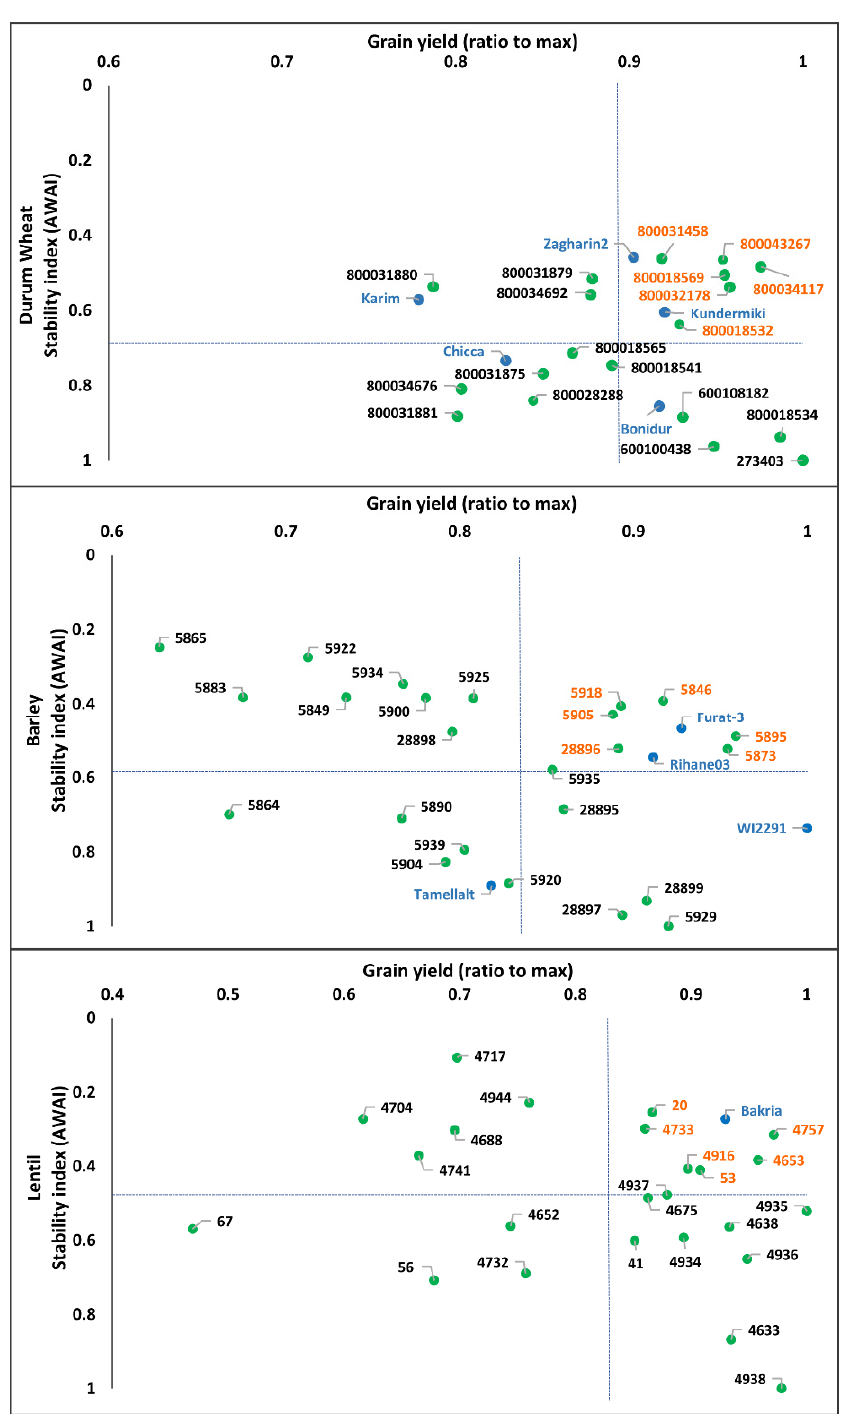
Figure 2. Combined analysis of nineteen environments for durum wheat, nine environments for barley, and nine environments for lentil presented as a biplot between genetic yield potential (G) and yield stability (G × E), expressed as the additive main effects multiplicative interaction (AMMI) wide adaptation index (AWAI). All values are presented as ratio to the maximum. Blue color is used to show the checks and green color to mark the CWR-derived lines. The grey lines correspond to the averages. The best yielding and the most stable CWR-derived lines are grouped in the top right corner and color coded in orange. All CWR-derived lines are presented by their GID